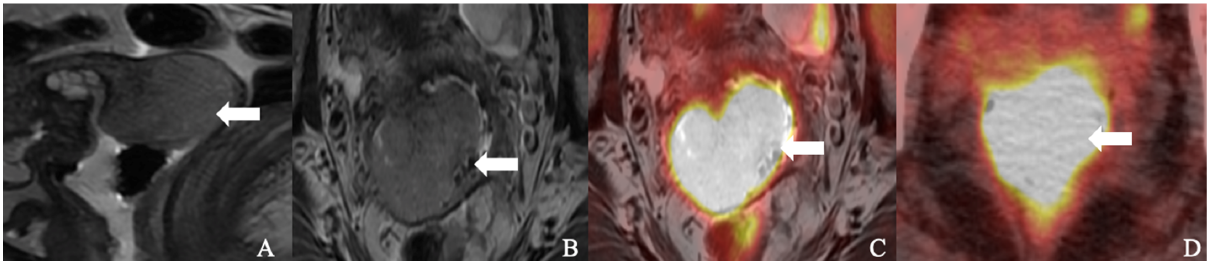
Figure 1. A 51-year-old woman with squamous cell carcinoma of the cervix. ( A ). Sagittal T2- weighted imaging (T2WI), ( B ). axial T2WI, and ( C ). axial fused T2WI positron emission tomography/MRI showing a large (18)F-fluorodeoxyglucose (FDG) avid cervical mass (arrow). ( D ). An axial positron emission tomography/computed tomography image showed FDG avidity cervical tumor (arrow).